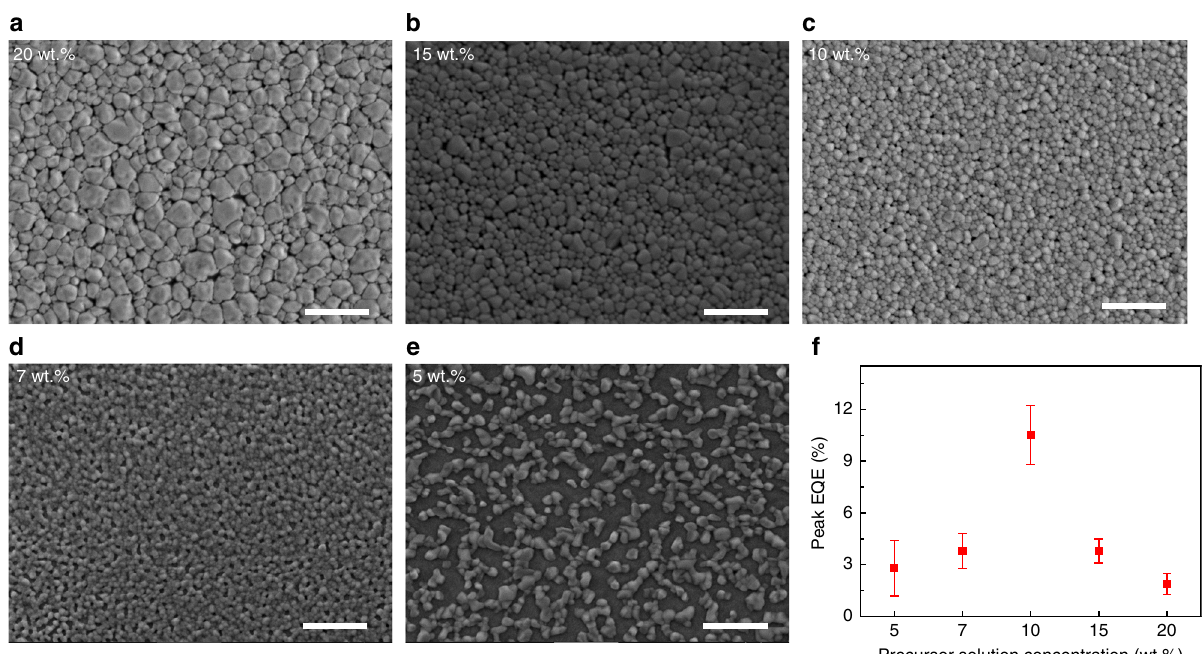
Fig. 3 SEM images of FAPbI 3 fi lms and EQE distribution of PeLEDs. Films and PeLEDs are fabricated with different concentrations of precursor solutions. a 20 wt.%. b 15 wt.%. c 10 wt.%. d 7 wt.%. e 5 wt.%. Scale bar, 1 μ m. f Peak EQE distribution for devices with different concentrations. More than 20 devices for each concentration. Error bars correspond to the standard deviation